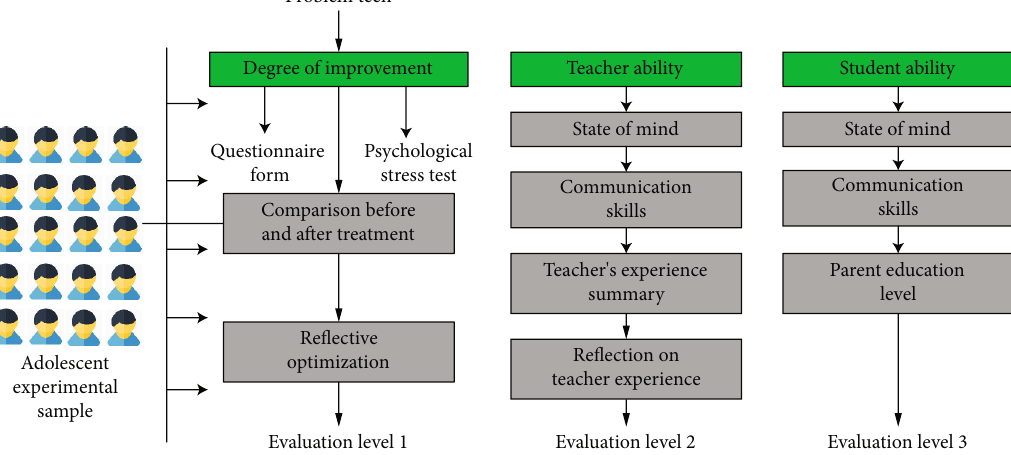
Figure 5: Experimental block diagram of psychological assistance treatment scheme for adolescents based on network information under the home-school coordination strategy. Table 1: Comparison of sample data and psychological test scores before and after treatment. Sample serial